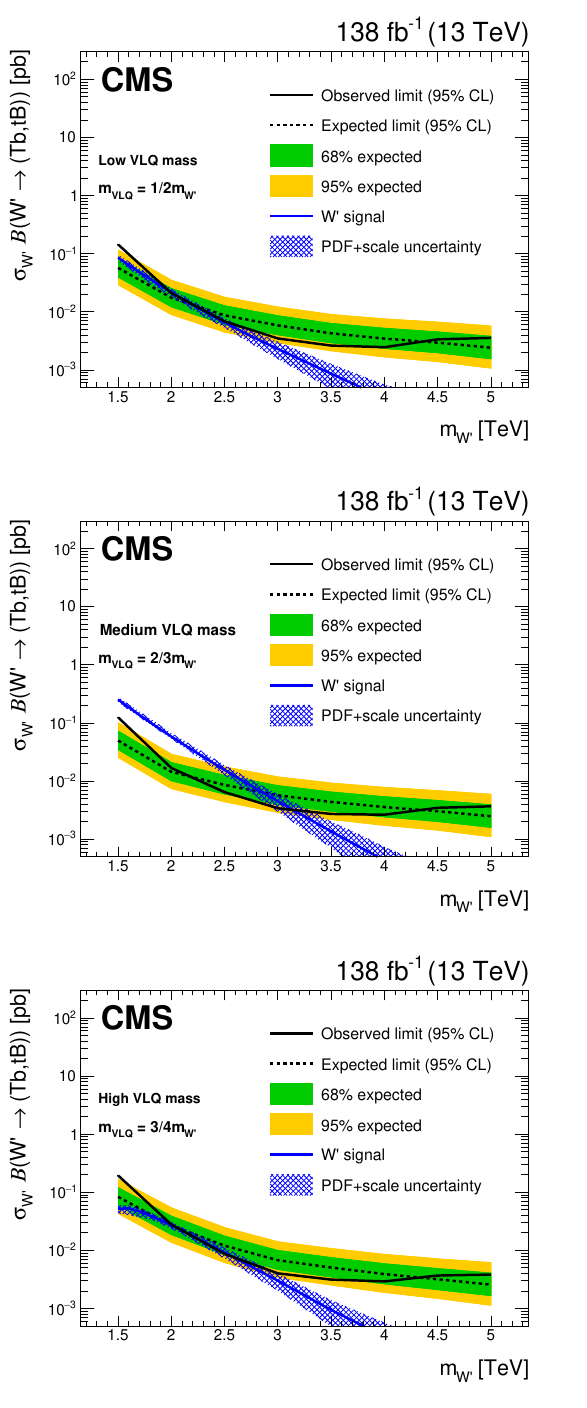
Figure 7 . The W 0 boson 95% CL limits on the product of cross section and branching fraction. The expected (dashed) and observed (solid) limits, as well as the W 0 boson theoretical cross section, with its PDF and scale normalization uncertainties, are shown. The green (inner) and yellow (outer) bands indicate the 68% and 95% confidence intervals of the expected limit. The limits are given for the low (upper), medium (center), and high (lower) VLQ mass